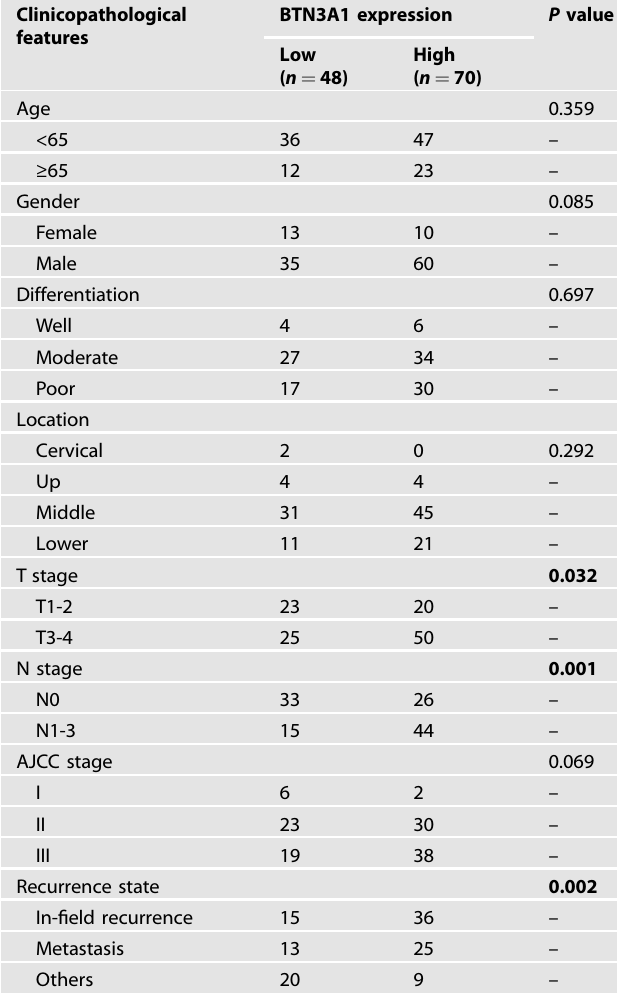
Table 1. The correlation of clinicopathological characteristics of ESCC patients receiving radiotherapy with BTN3A1